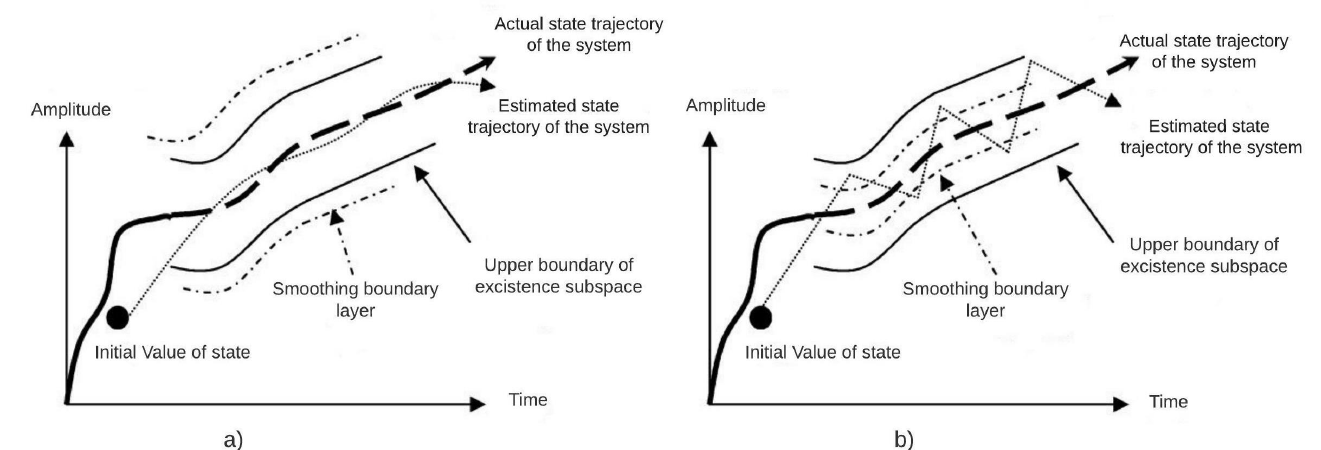
Figure 2. Effect of smoothing boundary layer ( a ) ψ > β , ( b ) ψ < β ( β is the upper boundary of existence